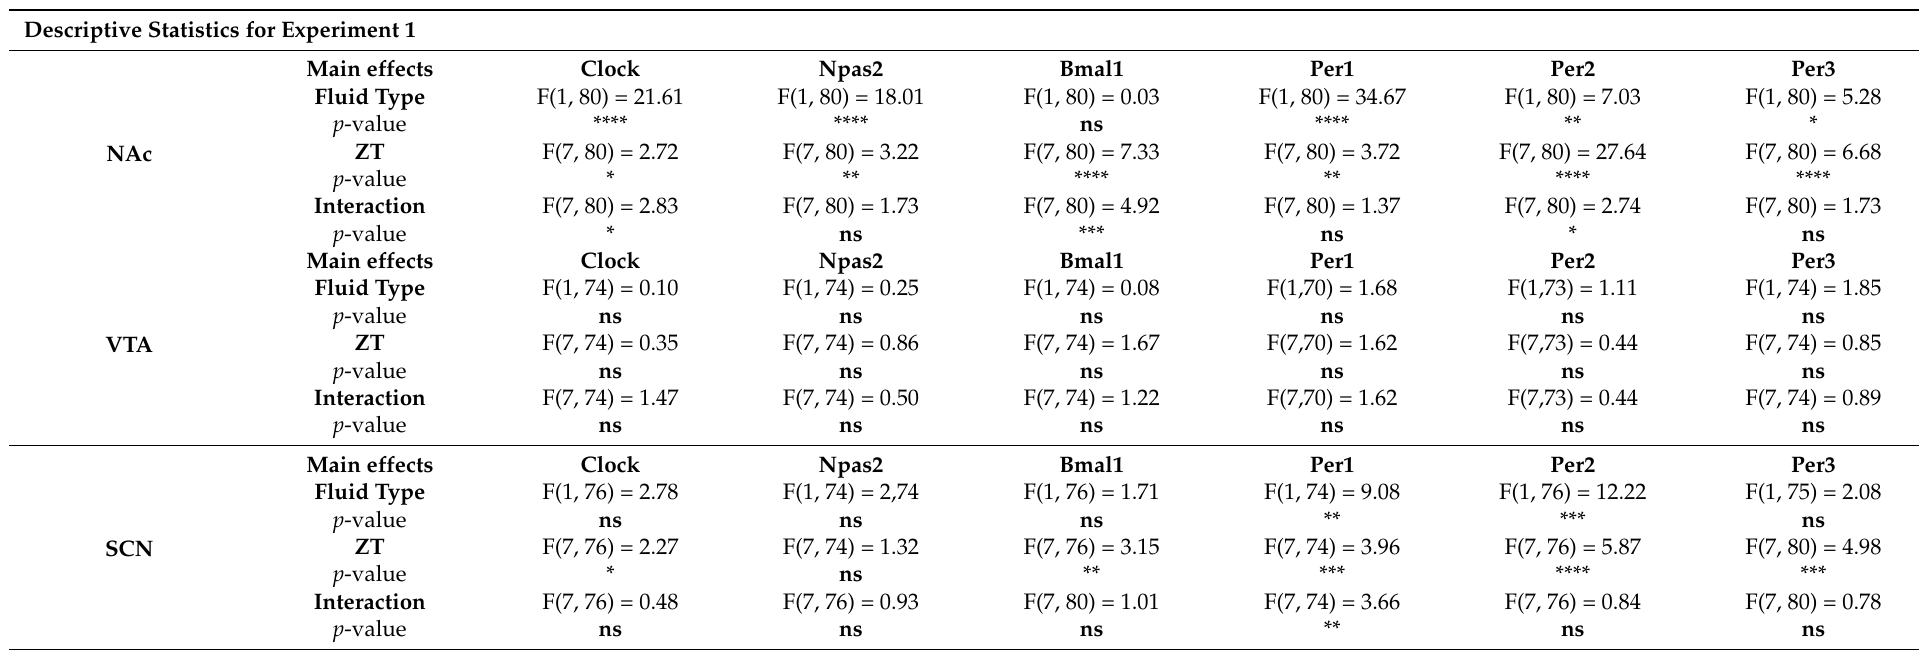
Table 1. Chronic binge-like ethanol drinking reduces expression of circadian genes in the NAc and SCN of female HDID-1 mice in Experiment 1. Descriptive statistics for the NAc, VTA, and